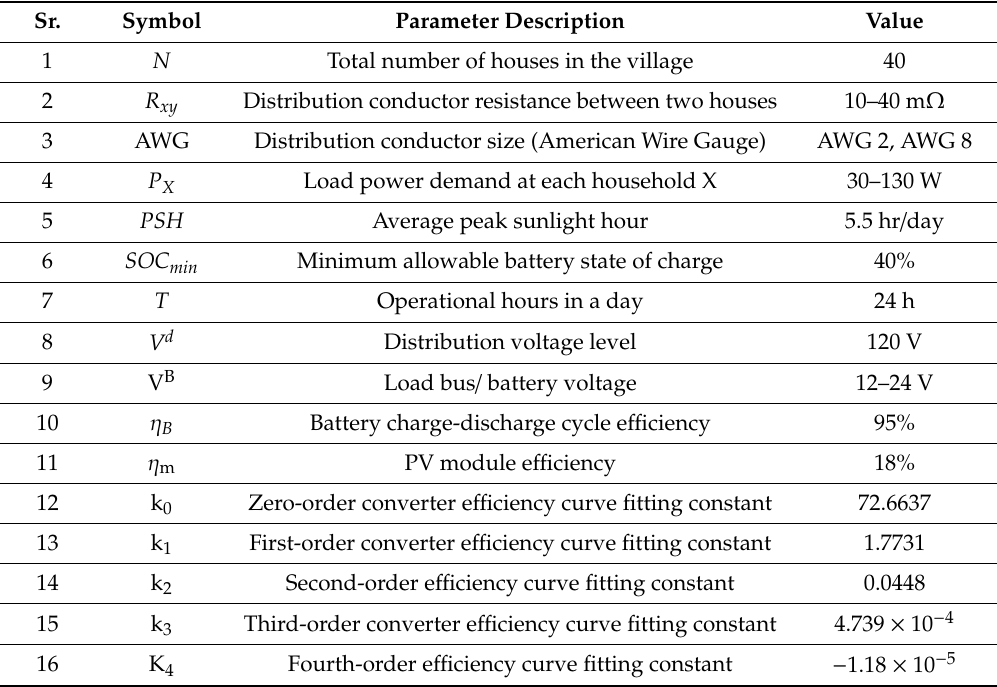
Table 2. Case study parameters.